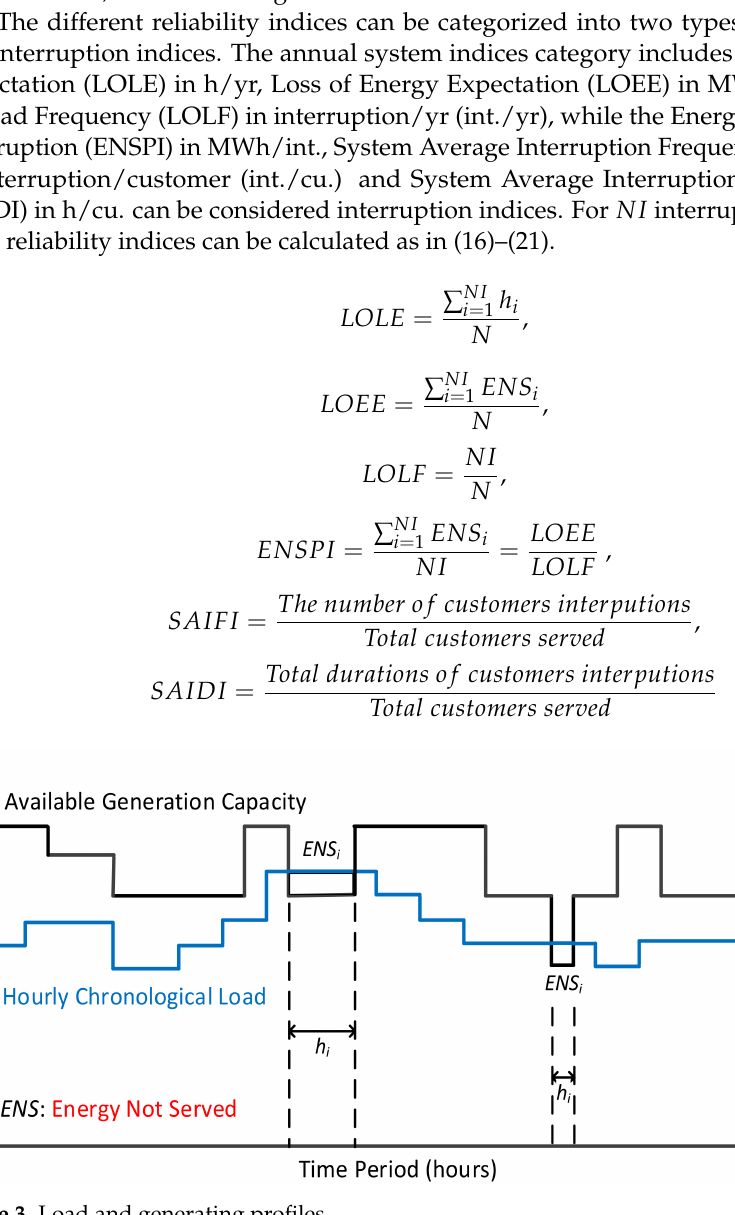
Figure 3. Load and generating